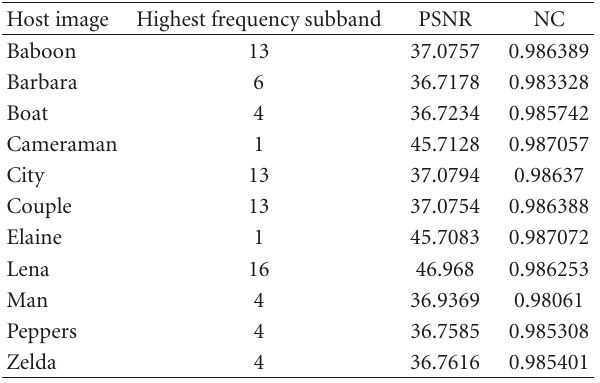
Table 2: Results of embedding more amounts of data into 16th and another directional subband.